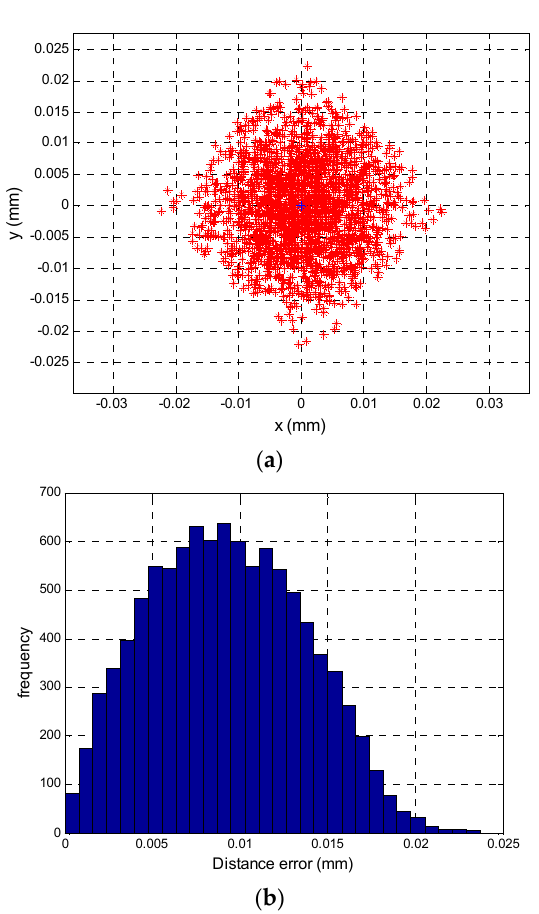
Figure 9. ( a ) Localisation error due to a temperature difference of ±5 °C at the central point; ( b ) Distribution of distance error for the central point.